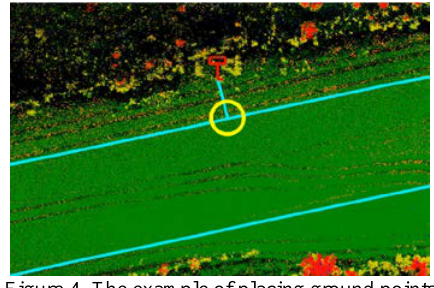
Figure 4. The example of placing ground points